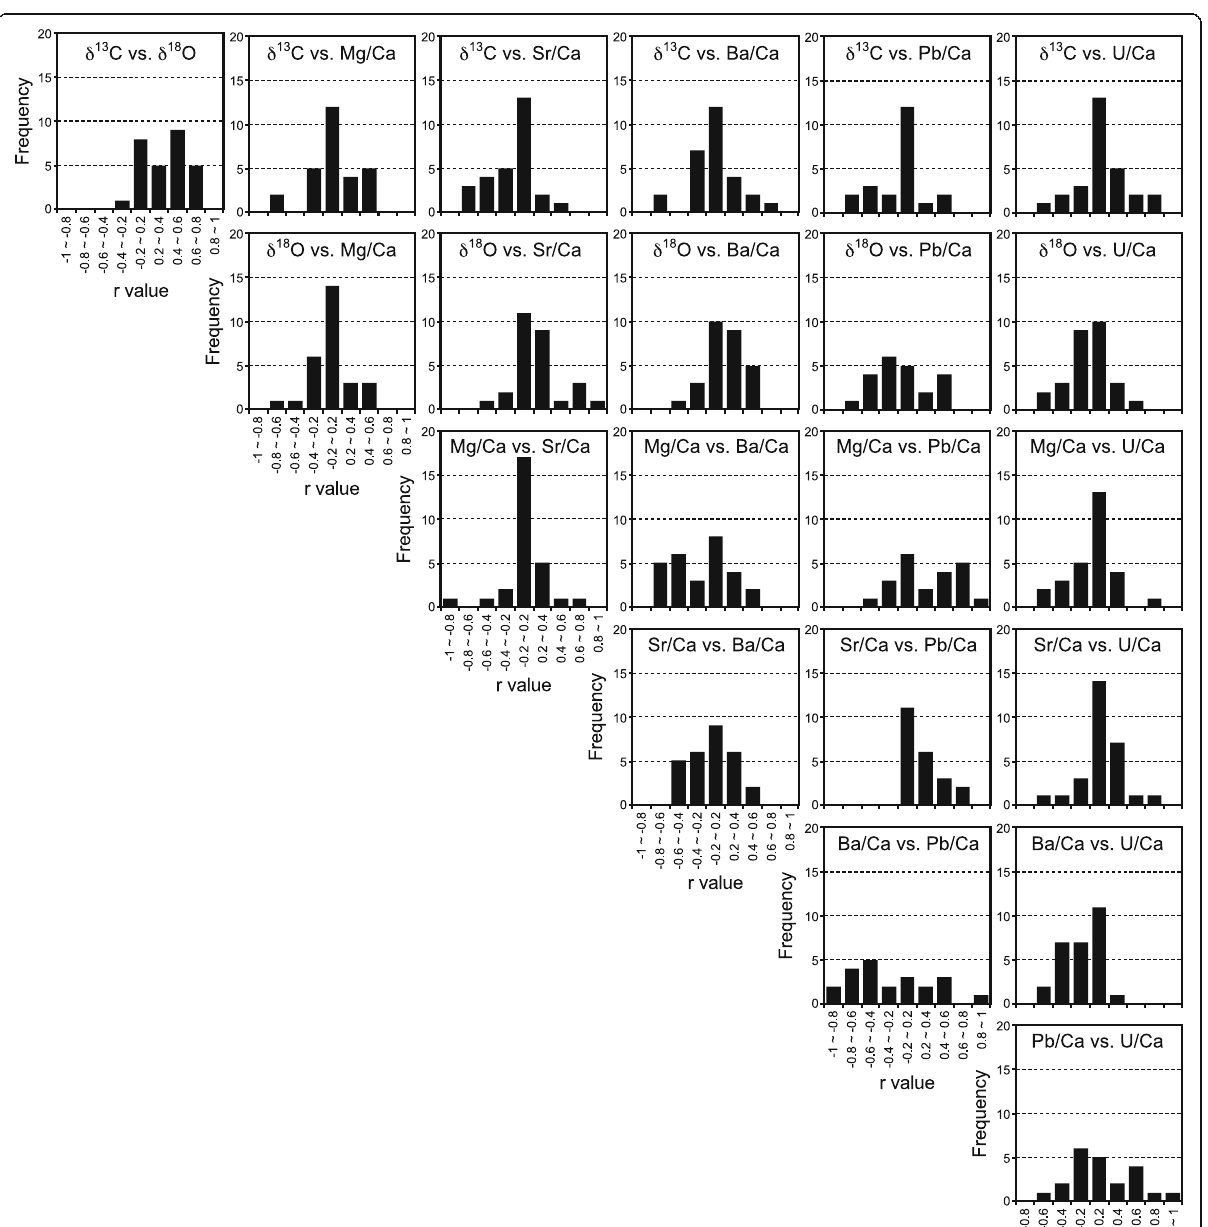
Fig. 7 Frequency distributions (histograms) of correlation coefficients among geochemical records of sclerosponges. The Y -axis represents the number of individuals (sample number: N ). The r values are divided into nine classes in the X -axis. A trend of the respective relations of two within-skeleton geochemical components is visualized. High frequency with r values of − 0.4 – 0.4 indicates a little significant relationship